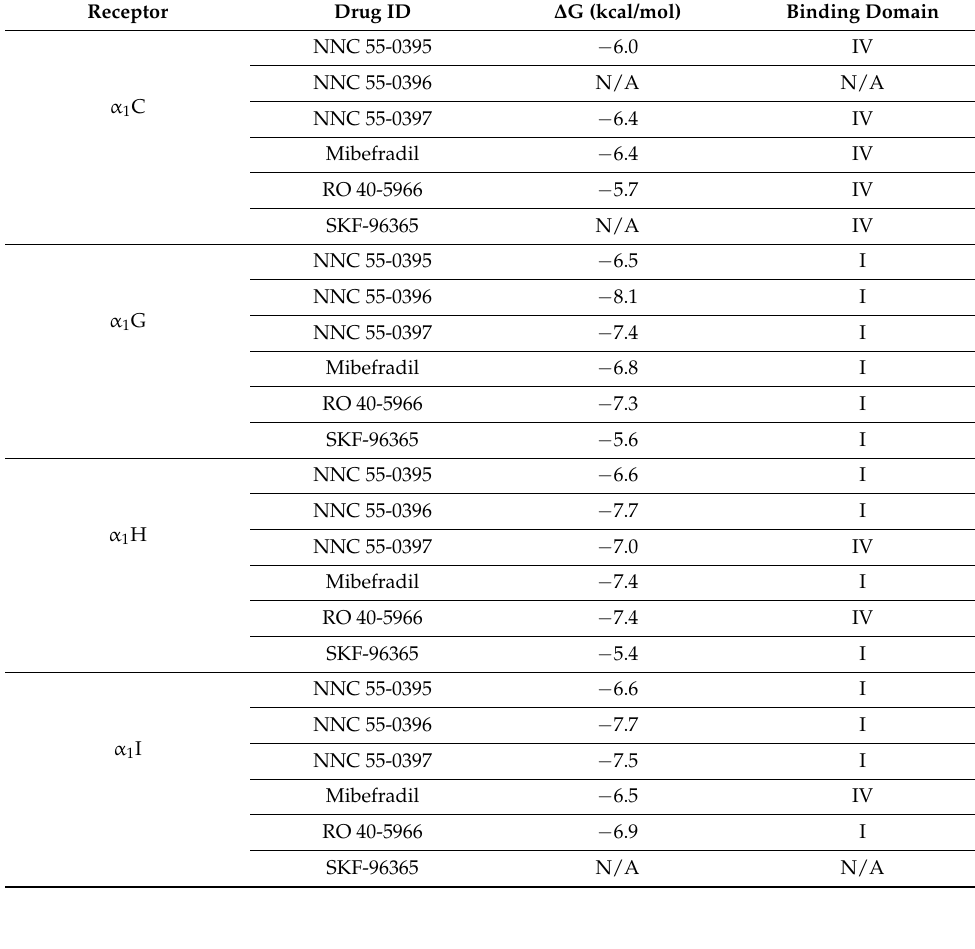
Table 2. Predicted Gibbs free energy ∆ G of phenylalkylamines (PAAs) on calcium channels (N/A: not available).